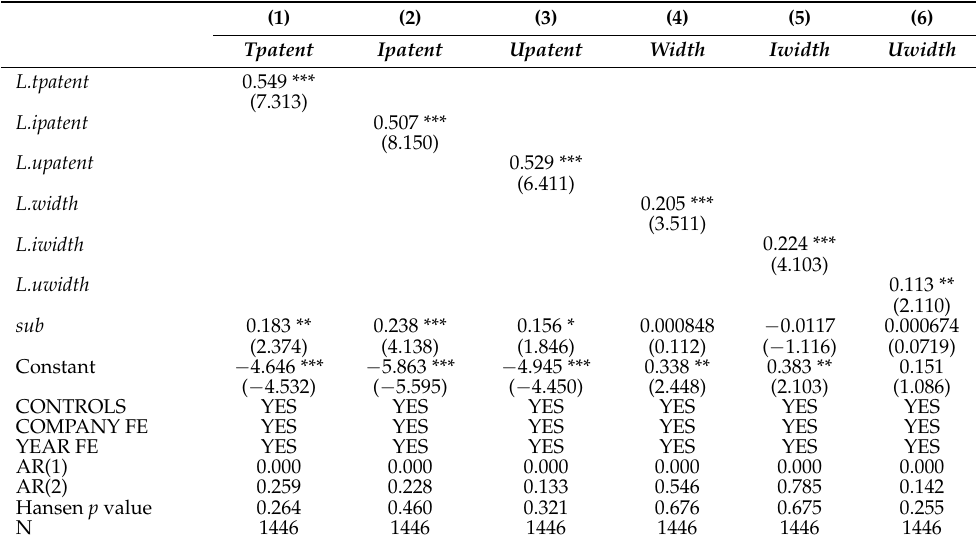
Table 9. Robustness test: System-GMM